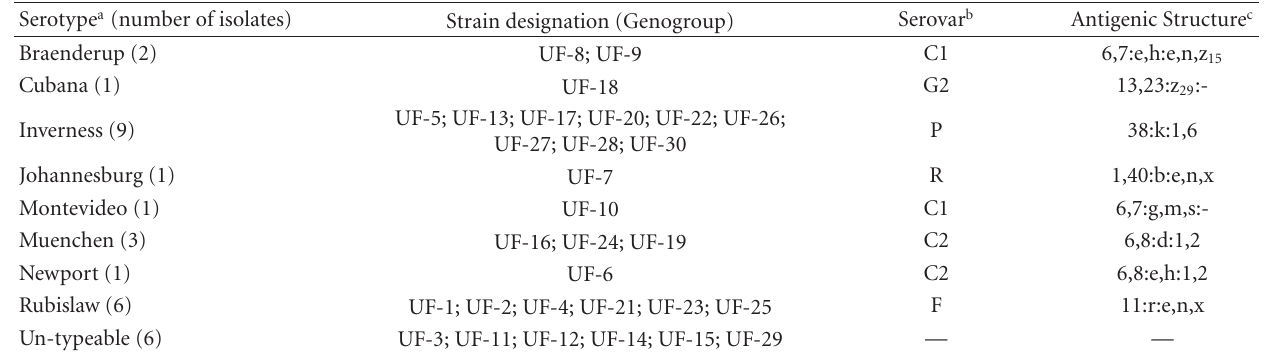
Table 5: Detailed serology of S. enterica isolated from Suwannee River